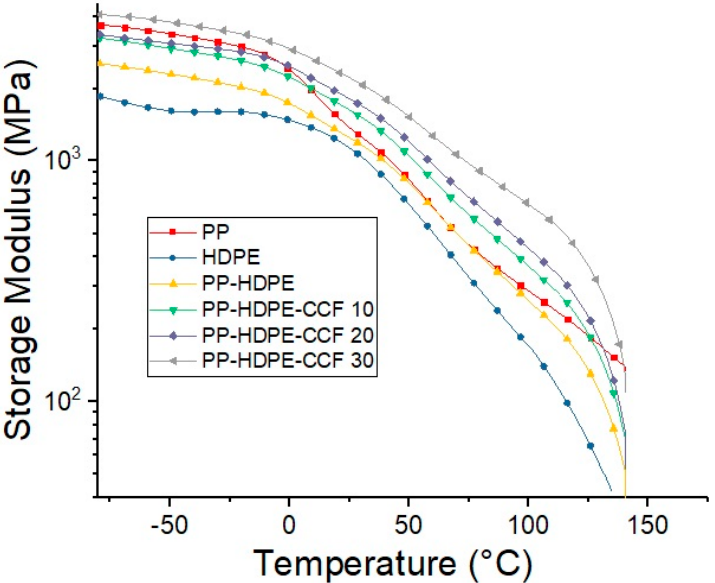
Figure9. Figure 9. Temperature dependence of storage modulus of PP, HDPE, PP-HDPE blend, and their biocomposites.